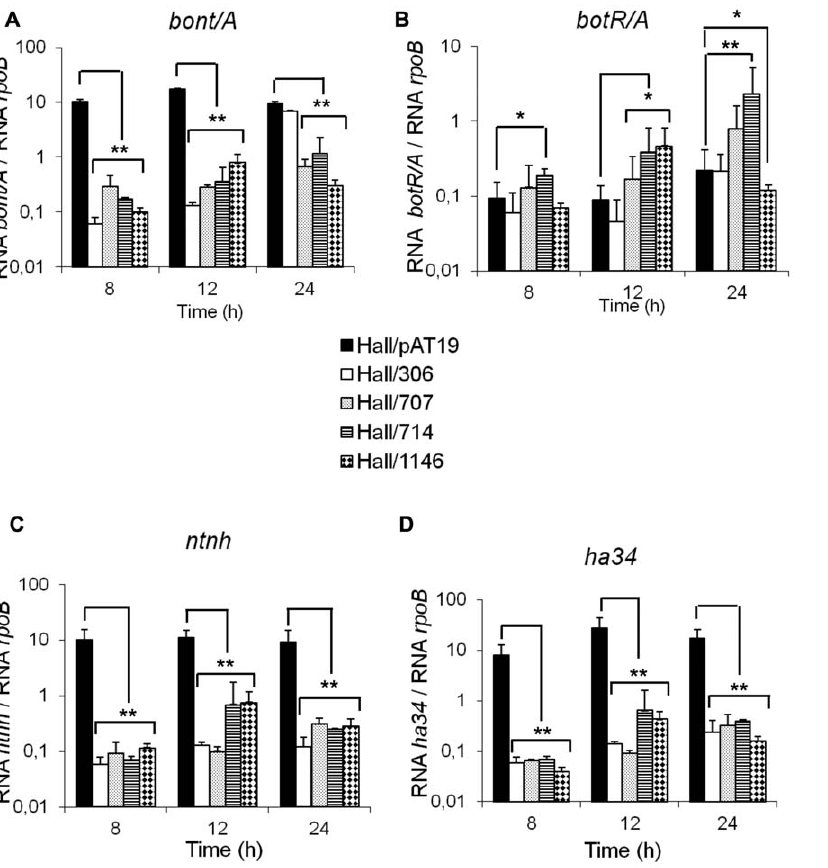
Figure 7. Kinetics of transcript levels of bont/A,botR/A,ntnh , and ha34 genes in Hall/707, Hall/714, and Hall/1146 versus Hall/pAT19 and Hall/306. Transcript levels were quantified by qRT-PCR and normalized versus rpoB gene. Data are mean values + / 2 SD, from 9 independent experiments where *P , 0.05 and **P , 0.005. doi:10.1371/journal.pone.0041848.g007 100 m l of goat peroxydase-linked antibody anti-rabbit Ig (111-035- 006, Jackson Immunoresearch) diluted at 1/5000 in PBST was added and plate were incubated 1 h under agitation. After the last three washes, detection of toxin was performed by adding 100 m l